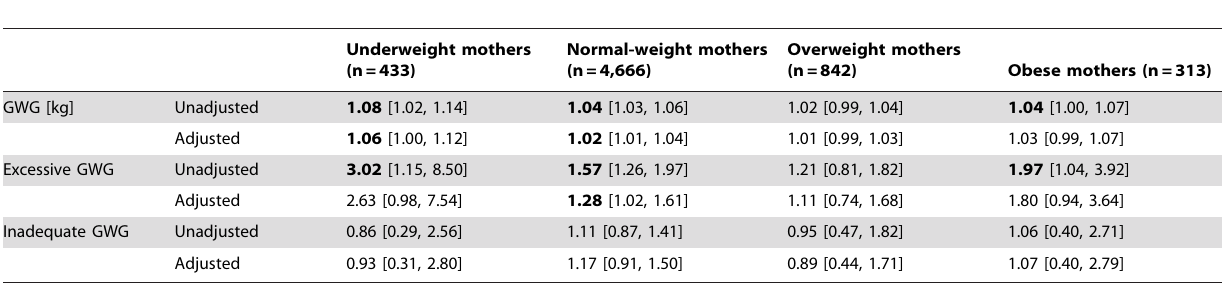
Table 3. Odds ratios [95% confidence intervals] for the associations of total, excessive and inadequate gestational weight gain (GWG) with offspring’s overweight (including obesity) at 5–6